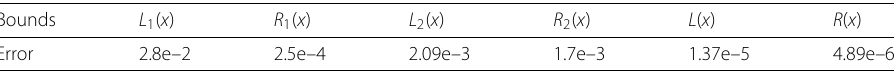
Table 1 Maximum errors between F ( x ) and its different bounds